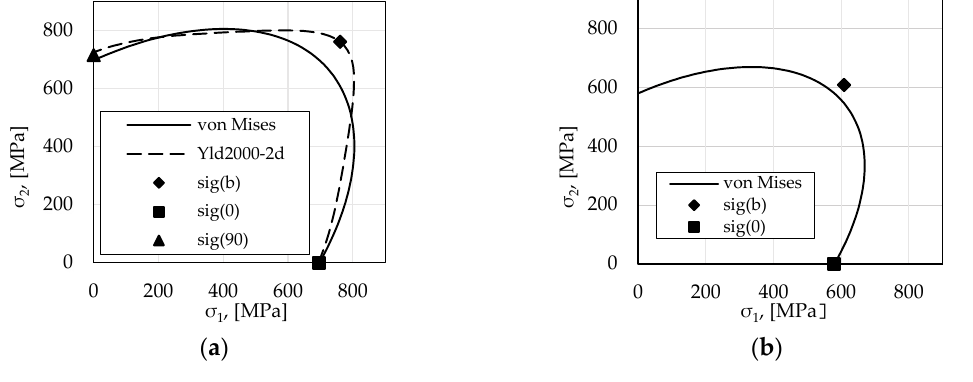
Figure 4. Yield locus for ( a ) TH700 ( b ) TH620. Table 3. Assessed parameters for selected materials.